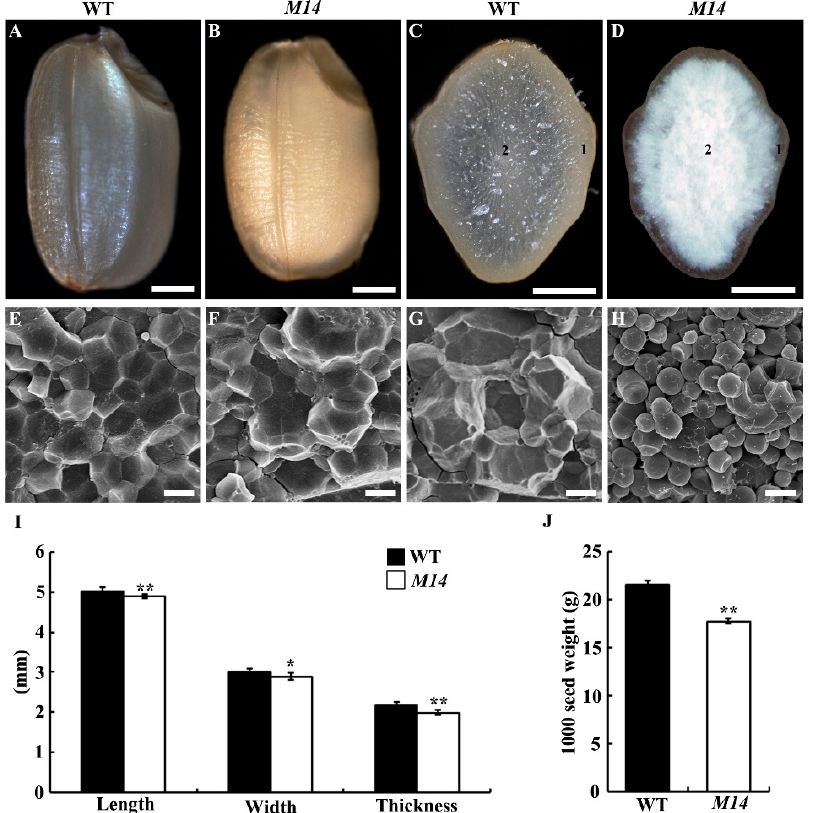
Figure 1. Phenotype analyses of M14 seeds. ( A , B ) The appearance of brown rice of WT and M14 . ( C , D ) Transverse sections of WT and M14 seed. Bars = 1 mm ( A – D ). ( E – H ) Scanning electron microscope observation of WT and M14 seeds. ( E , F ) represent the region of “1” and “2” in WT endosperm, respectively, and ( G , H ) represent the region of “1” and “2” in M14 endosperm, respectively. Bars = 5 µ m ( E – H ). ( I ) Seed length, width, and thickness of WT and M14 ( n = 20). ( J ) 1000-seed weight of WT and M14 . Data are given as means ± SD ( n = 3). ** and * indicate significant differences between WT and M14 at p < 0.01 and p < 0.05 by Student’s t test.